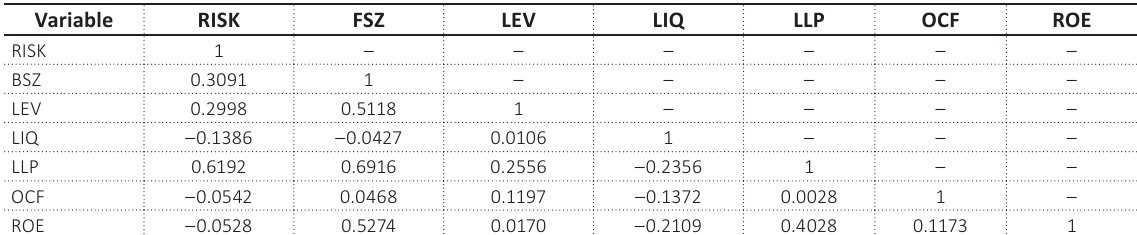
Table 3. Correlation matrix for variables included in the model